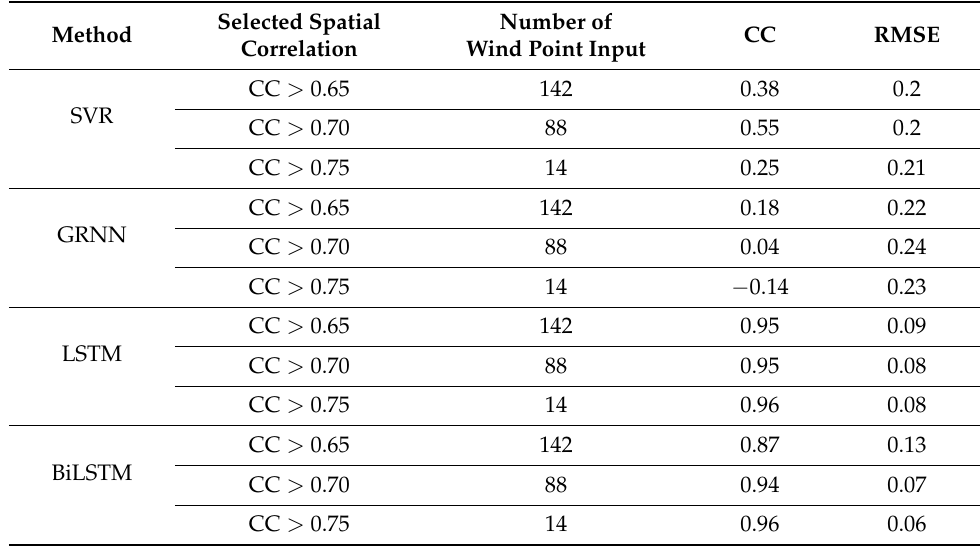
Table 2. Comparison of different methods using selected spatial